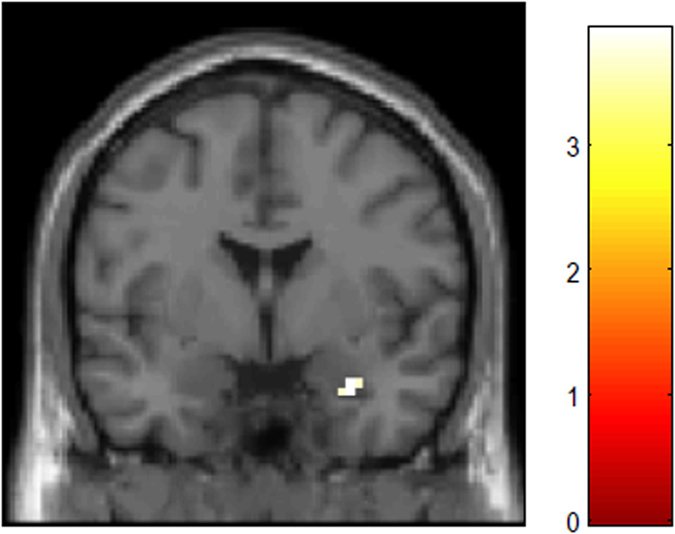
The right amygdala displays greater effective connectivity with the left pulvinar during the observation of unattended fearful faces vs. neutral faces.MNI coordinate: 30 −1 −26. Significant at FWE-corrected p < 0.05 with small volume correction. Colour bar indicates T-value.